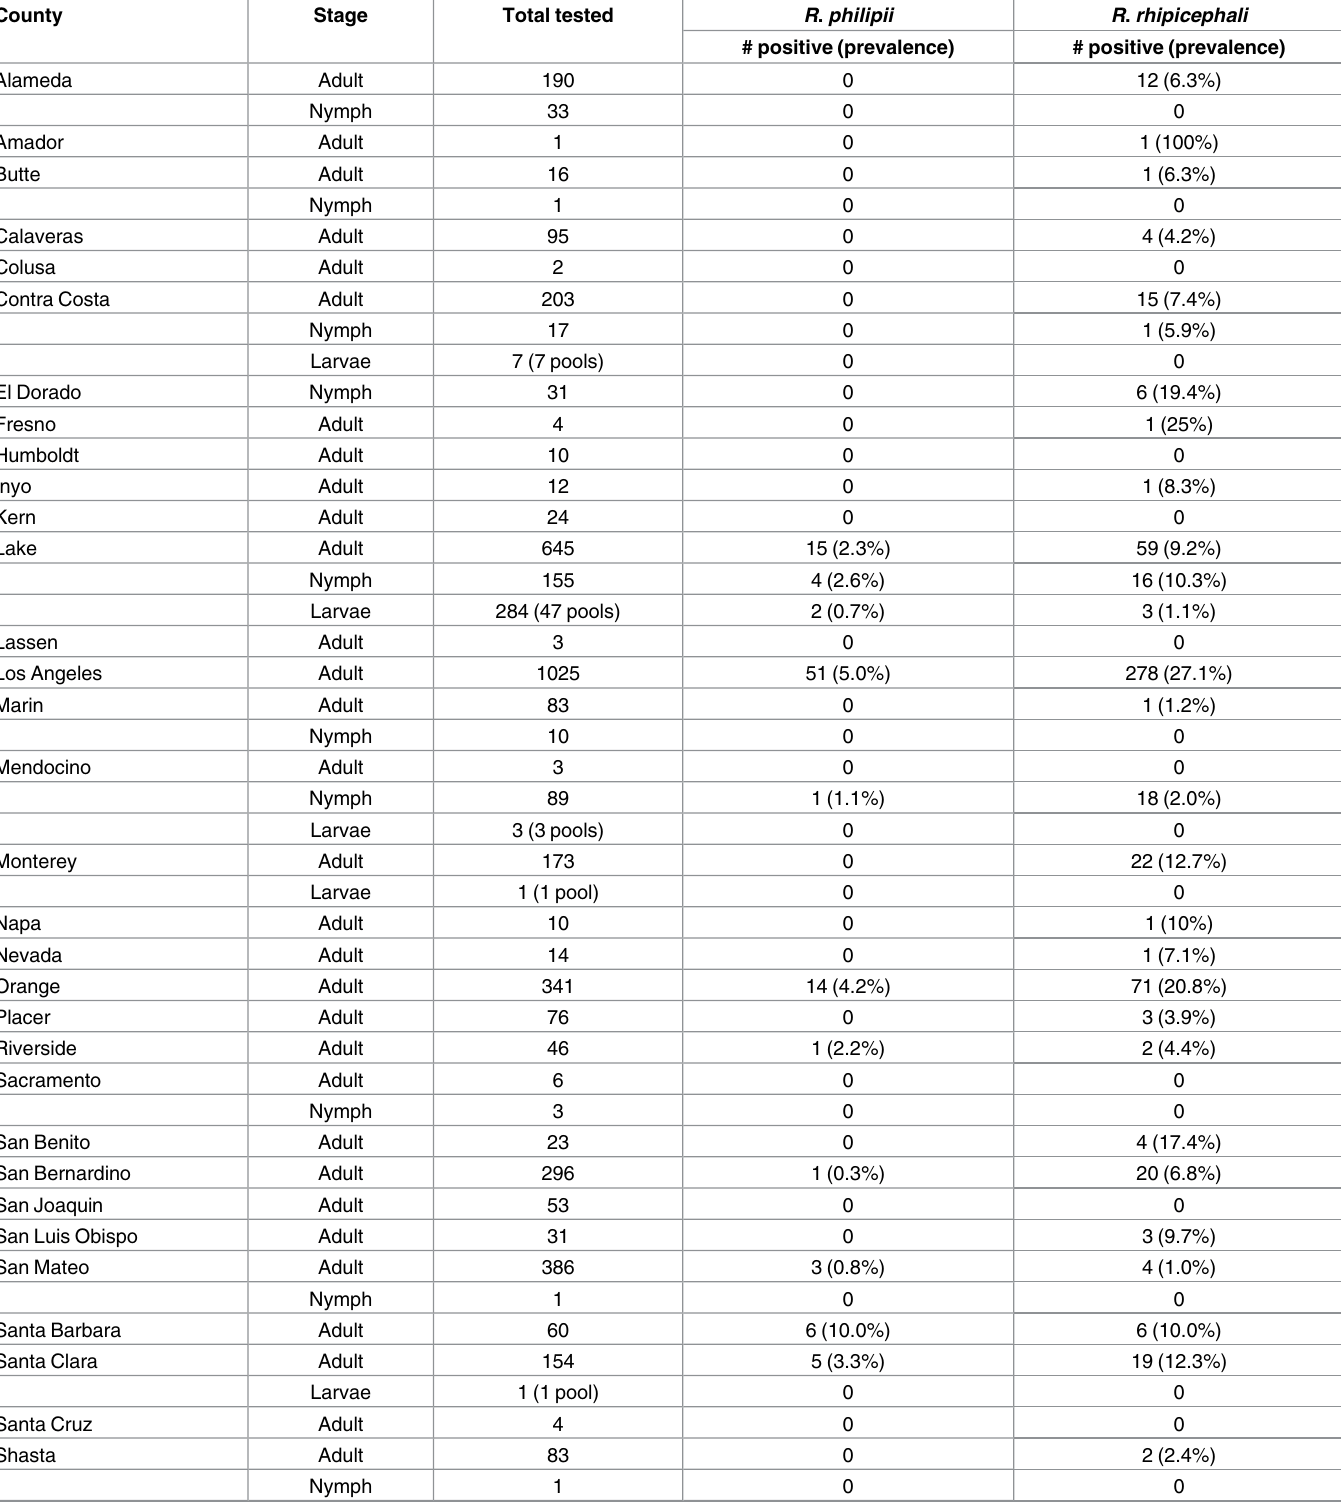
Table 3. Prevalence of Rickettsia philipii and Rickettsia rhipicephali detected in Dermacentor occidentalis , by county, California, 2009–2015.